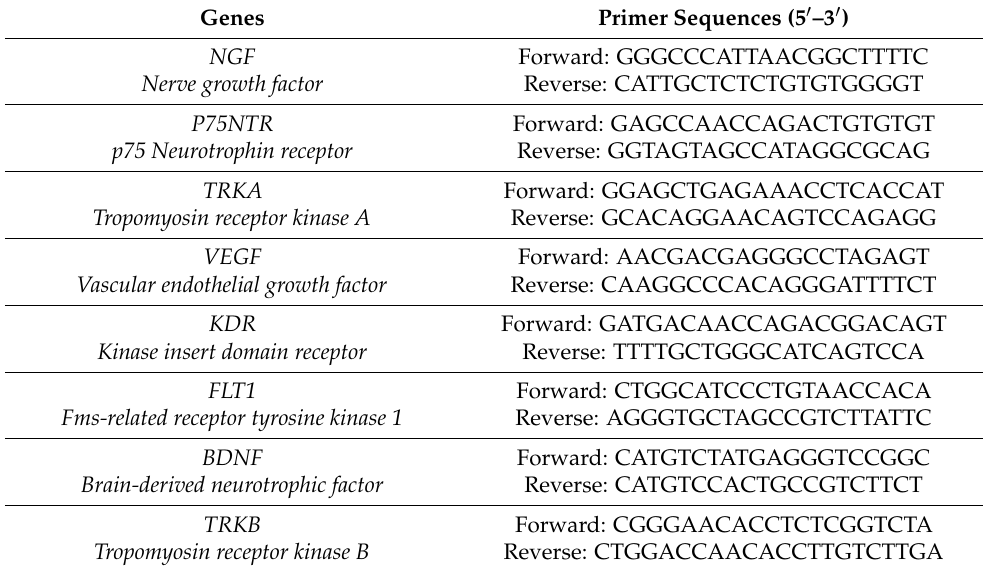
Table 1. List of the gene-specific primer sequences.